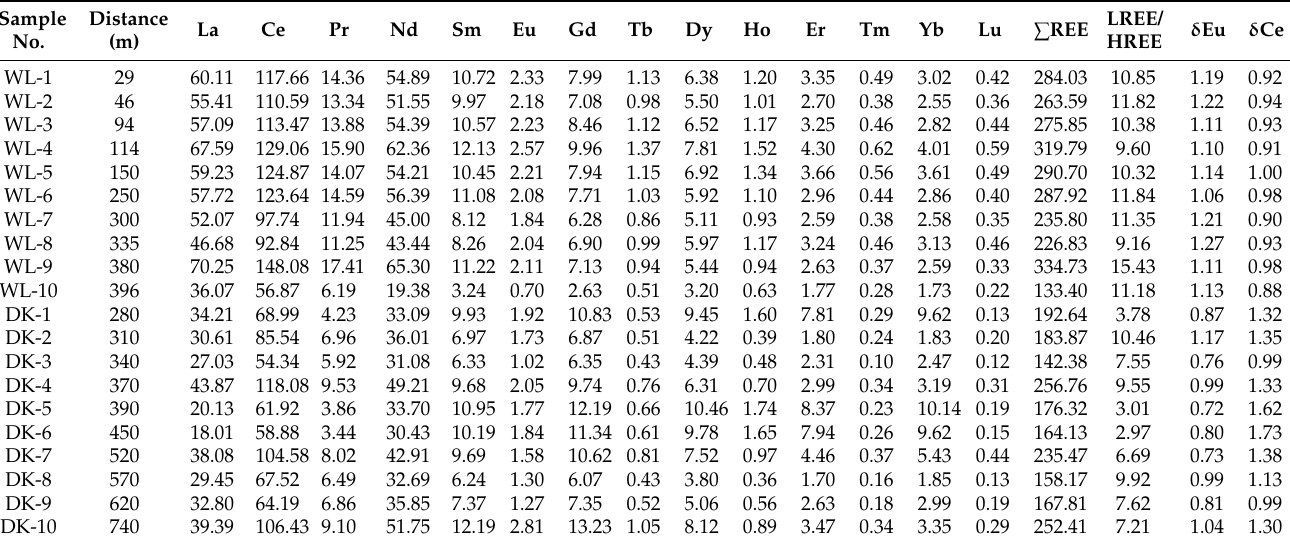
Table 2. Rare earth elements of the Beipiao samples, in µ